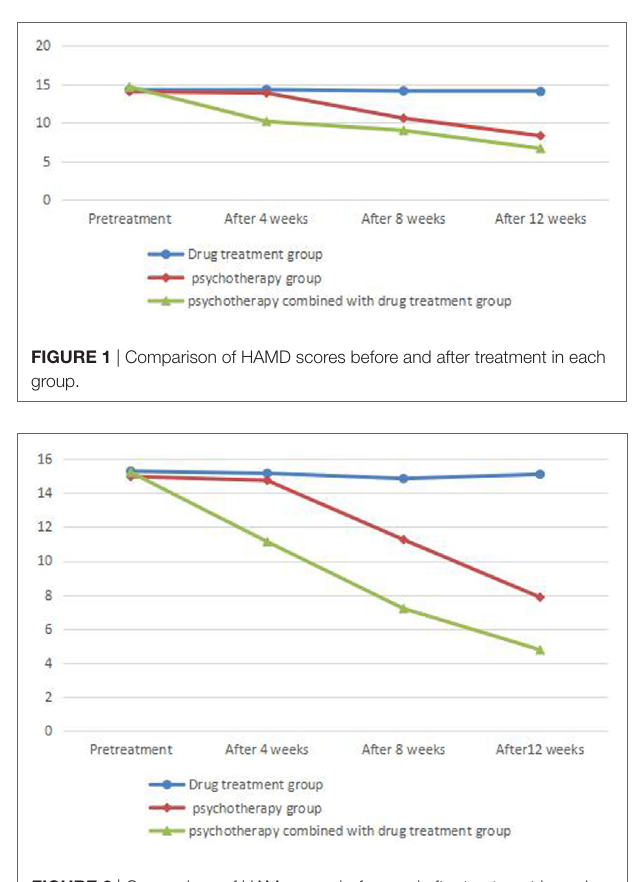
FigUre 2 | Comparison of HAM scores before and after treatment in each group.